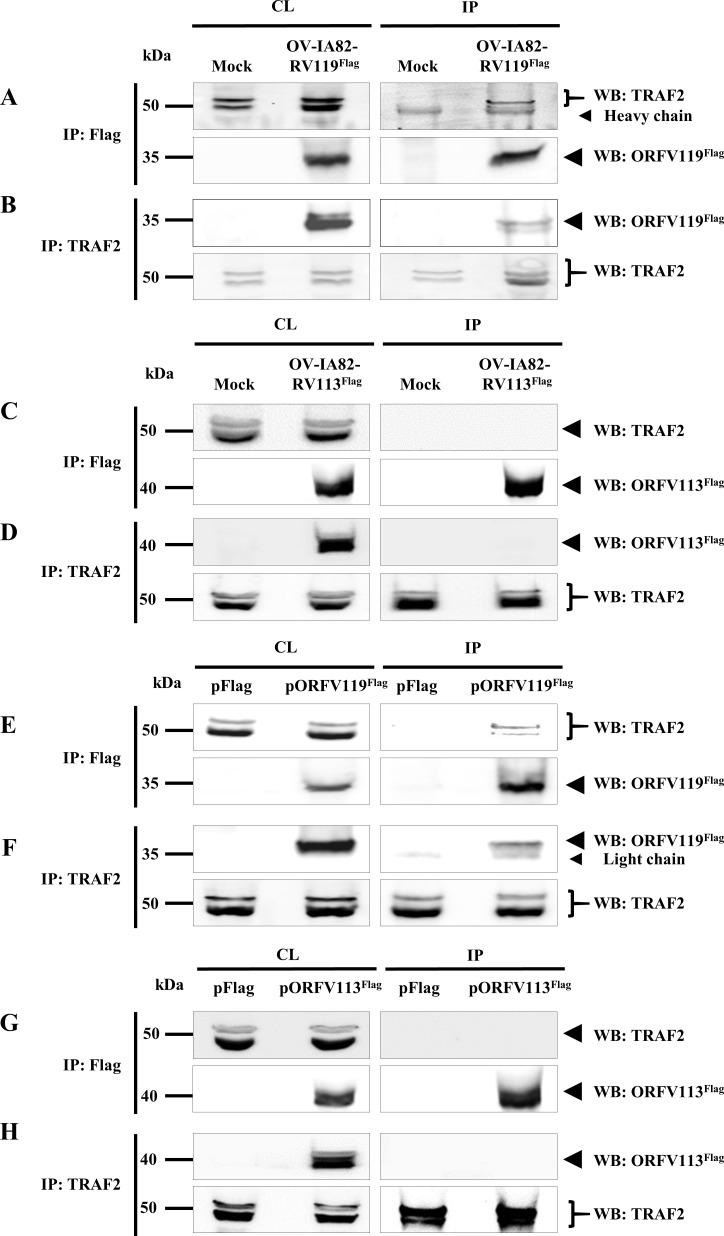
Co-immunoprecipitation of ORFV119 with TRAF2.(A-D) OFTu cells were mock infected or infected with OV-IA82-RV119Flag or OV-IA82-RV113Flag (MOI, 10) and harvested at 12 h p.i. Total cell lysate and protein extracts immunoprecipitated with anti-Flag (A and C) or anti-TRAF2 (B and D) antibodies were examined by Western blot using anti-TRAF2 or anti-Flag antibodies. (E-H) 293T cells were transfected with control plasmid (pFlag), pORFV119Flag or pORFV113Flag and harvested at 12 h post transfection. Total cell lysate and protein extracts immunoprecipitated with anti-Flag (E and G) or anti-TRAF2 (F and H) antibodies were examined by Western blot using anti-TRAF2 or anti-Flag antibodies. Results are representative of three independent experiments. Percentage of (A) TRAF2 co-immunoprecipitated by ORFV119Flag in OV-IA82-RV119Flag infected cells: 35.3±2.7%; (B) ORFV119Flag co-immunoprecipitated by TRAF2 in OV-IA82-RV119Flag infected cells: 24.7±1.25%; (E) TRAF2 co-immunoprecipitated by ORFV119Flag in pORFV119Flag transfected cells: 23.7±2.1%; (F) ORFV119Flag co-immunoprecipitated by TRAF2 in pORFV119Flag transfected cells: 18.1±2.02%.